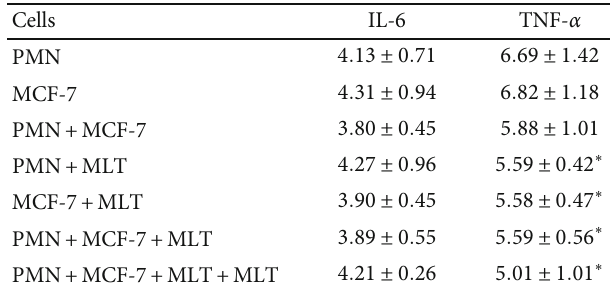
Table 3: IL-6 and TNF- α concentrations (pg/ml) in the culture supernatant of colostrum PMN cells cocultured or not with MCF- 7 cells after 72 hours of